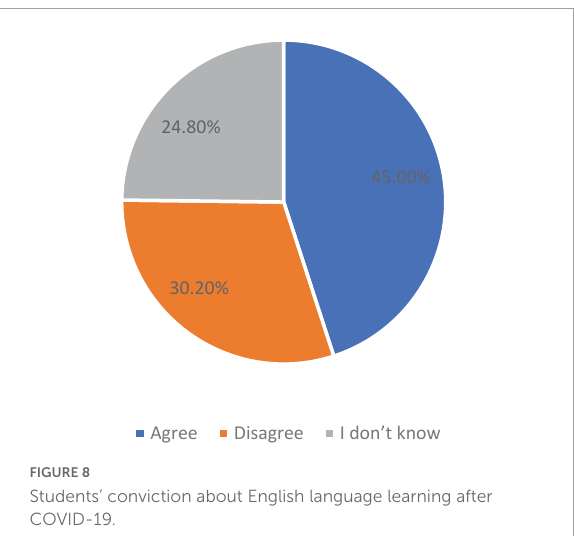
FIGURE7 Virtual learning enables me to learn the English language independently.